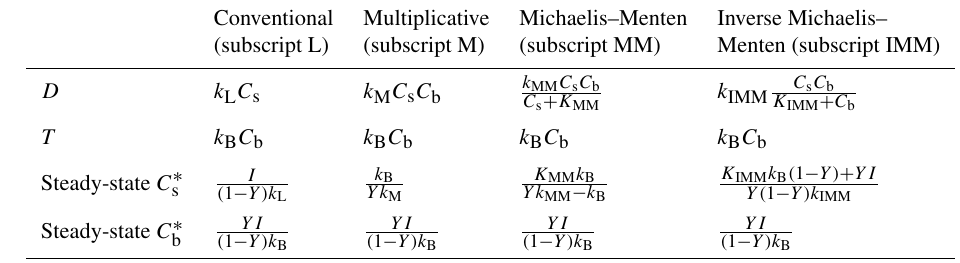
Table 1. Summary of the microscopic decomposition functions and steady-state solutions.